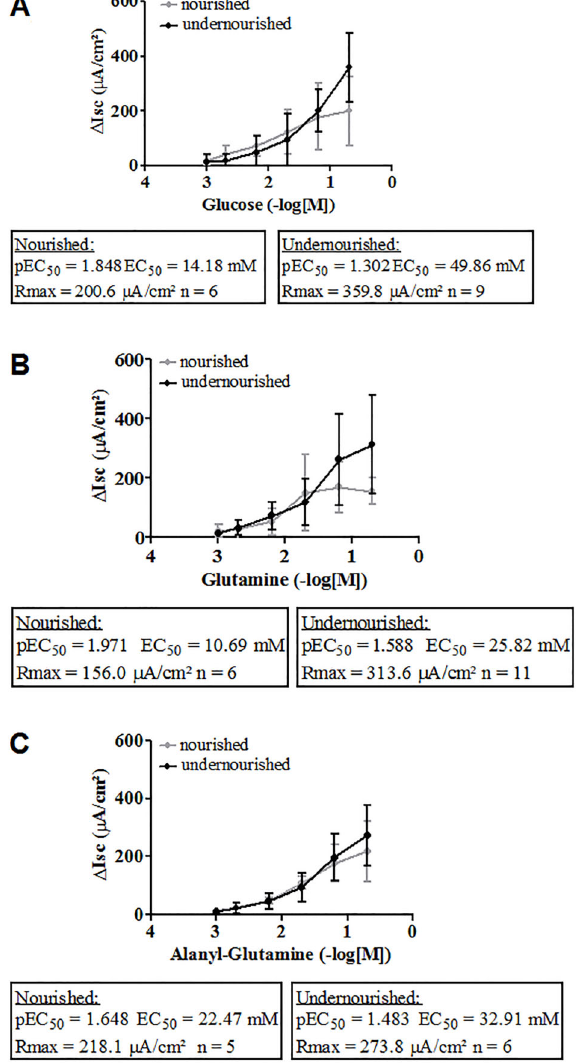
Figure 5. Short-circuit current (I sc ) measured after cumulative addition of glucose ( A ), glutamine ( B ), and alanyl-glutamine ( C ). Substrates were added at increasing concentrations (1, 2, 7, 20, 70, and 200 mM) at 30 min time intervals with subsequent measurement of I sc . Results are reported as means ± SE (n = 5 – 11 Ussing chambers from four mice). P o 0.05, maximum responses were signi fi cantly different between groups only for the maximum glucose concentration (two-way ANOVA followed by the Bonferroni post hoc